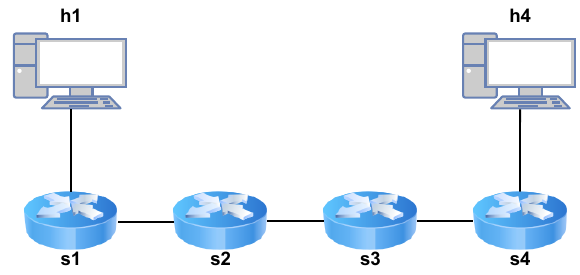
Figure 6. Network for the 3-links path OWD calculation.